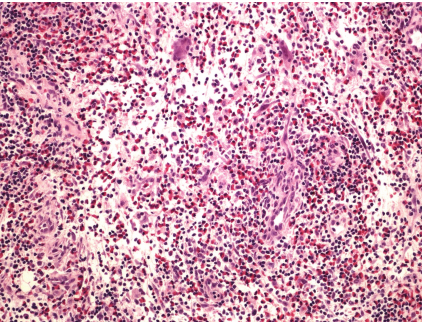
Figure 1: Large quantity of eosinophilic granulocytes, growth of small venules (H&E staining, microscopic magnification of × 40).